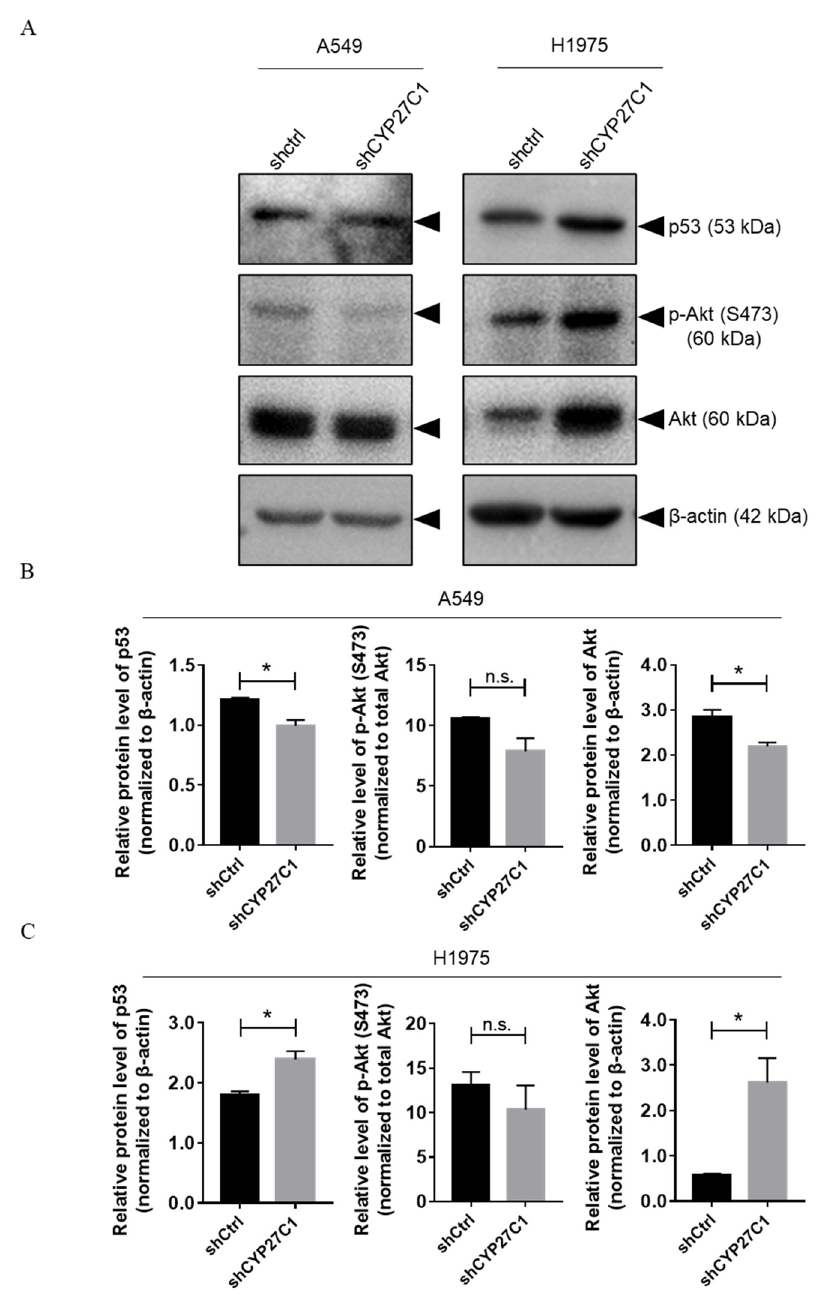
Figure 7. Stable CYP27C1-knockdown alters Akt-p53 signal transduction in human lung cancer cells. ( A – C ) A549-shCYP27C1, H1975-shCYP27C1, and the corresponding control cells were seeded in 6-well plate for 24 h before protein extraction and quantitation. Total Akt, phosphorylated Akt,